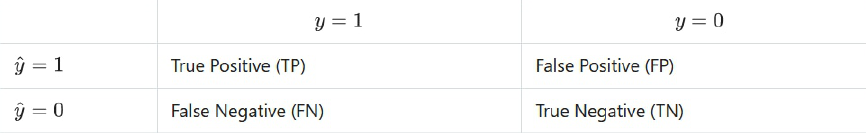
Figure 13. Error matrix. ˆ y is the algorithm response to the object, and y is the true class label of this object.